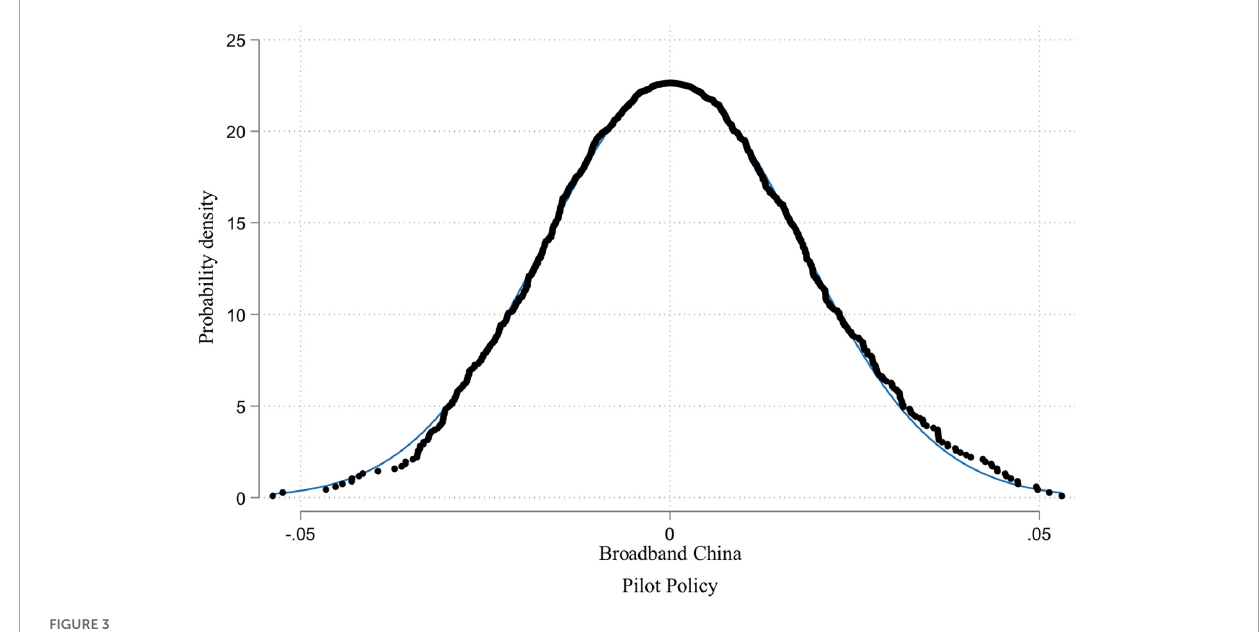
FIGURE3 Placebo test.